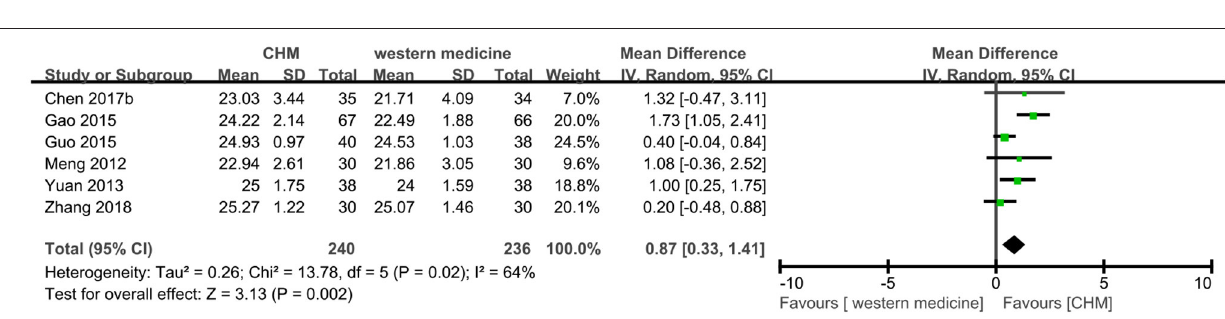
FIGURE 9 | Forest plot of comparison: CHM vs. western medicine, outcome: MoCA.